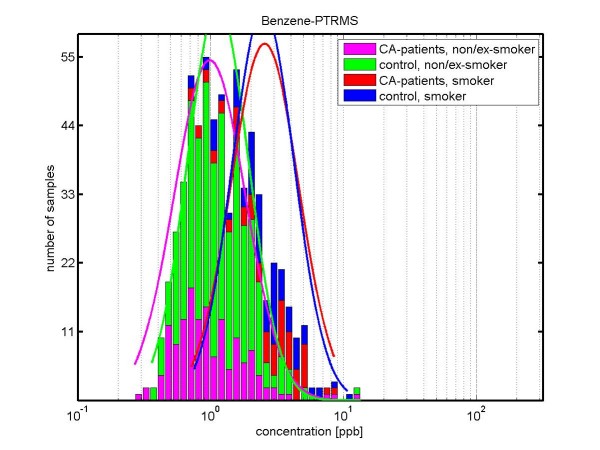
Concentration distributions of benzene (determined by PTR-MS) in exhaled breath of lung carcinoma patients (smokers: red; non/ex-smoker: magenta) and healthy volunteers (smokers: blue; non/ex-smokers: green). The concentration is shown in logarithmic scaling. Benzene concentration is increased in the subgroups of smokers and therefore a marker for smoking behavior. The median values for benzene in human breath have been determined as follows: CA-patients-non/ex-smoker 0.9 ppb, control-non/ex smokers 1.1 ppb (significant difference according to Kruskal-Wallis test: p-value 0.002); CA-patients-smoker 2.9 ppb, control-smokers 2.4 ppb (no statistical significant difference according to Kruskal-Wallis test: p-value 0.469). The difference in smoking behaviour (between smoker and non/ex-smoker) is statistically significant for the control group (p-value < 1*10-5) as well as for the CA-patients (p-value < 1*10-5).